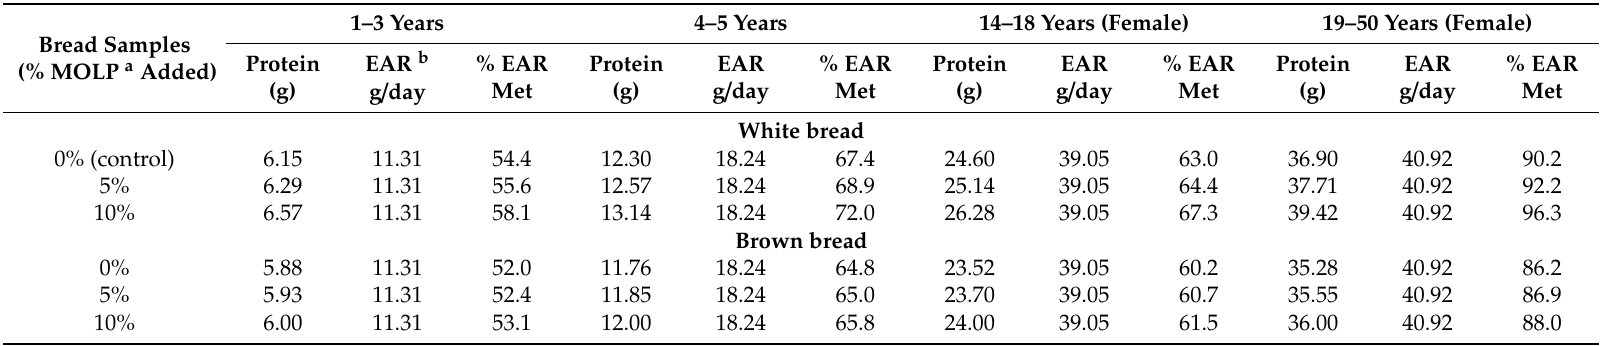
Table 4. Percentage of the estimated average requirement met for protein for vulnerable population groups using the estimated portions of bread. Bread